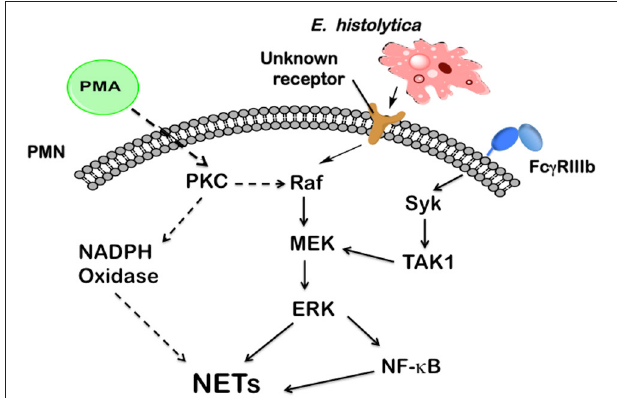
FIGURE 14 | Model for signaling in neutrophils to induce NETosis after Entamoeba histolytica engagement. In human neutrophils, phorbol 12-myristate 13-acetate (PMA) can directly activate (dashed arrows) protein kinase C (PKC), which in turn leads to activation of the Raf/MEK/ERK pathway. These kinases finally promote NETs formation. PKC is also required for NADPH-oxidase activation to form reactive oxygen species, which are required for NETs formation after PMA stimulation. In contrast, E. histolytica trophozoites are recognized by neutrophils via a, yet unknown, receptor, which connects to the Raf/MEK/ERK pathway. Also the nuclear factor kappa B (NF- κ B) is activated to promote NETs formation. The antibody receptor Fc γ RIIIb also induces NETs formation via spleen tyrosine kinase (Syk) and transforming growth factor- β -activated kinase 1 (TAK1), which connects to MEK (Alemán et al., 2016b). Other signaling molecules (not shown), such as phosphatidylinositol 3-kinase (PI3K), and p38 MAP kinase are not involved in E. histolytica signaling to NETs